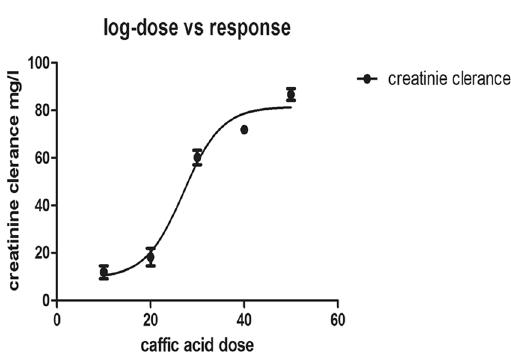
Figure 6. Flow chart of animal groups.